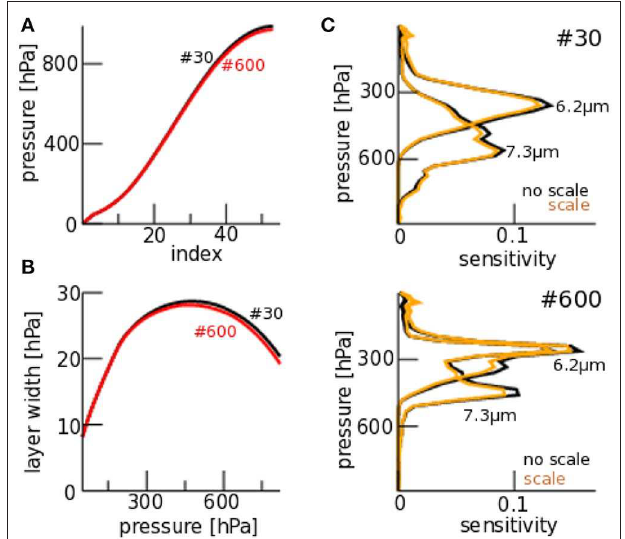
FIGURE 3 | RTTOV vertical pressure levels and their scaling. (A) Pressures in the vertical grid as function of the level index for two example atmospheric columns # 30 (black) and # 600 (red). (B) Width of the pressure layers as function of the corresponding pressure for both atmospheric columns. (C) Non-scaled vertical sensitivity function w ( p n ) (black lines) and scaled sensitivity function ¯ w ( p n ) (orange line) for both channels and both atmospheric